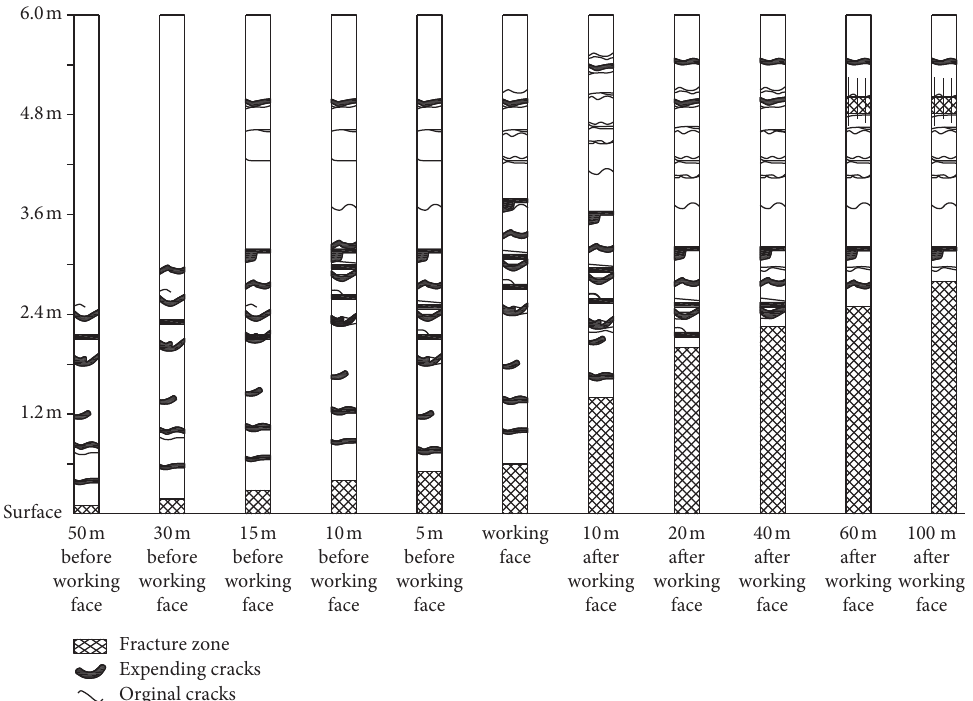
Figure 3: Sketch of cracks and fractures zones in retained coal rib around working face.